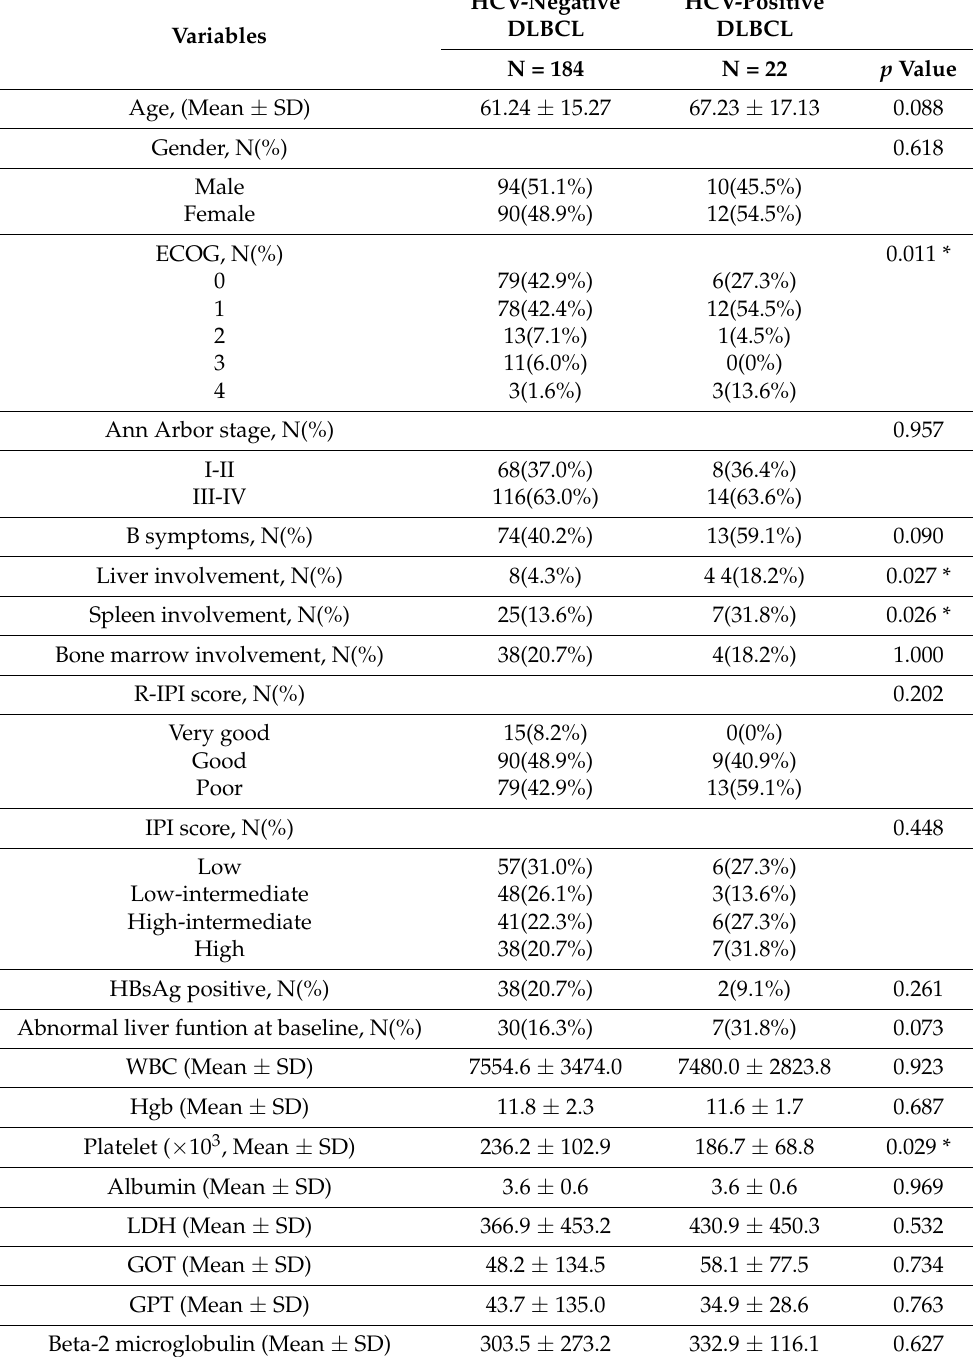
Table 1. Baseline characteristics of HCV-negative and HCV-positive DLBCL